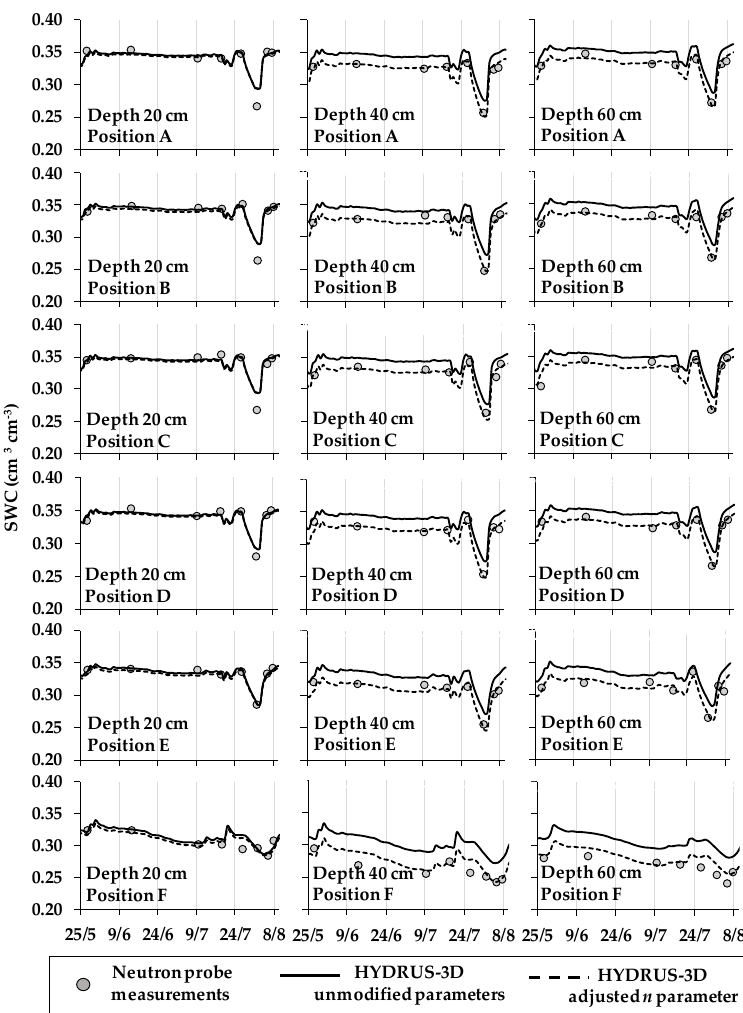
Figure 7. Soil water content (cm 3 cm − 3 ) simulated with HYDRUS-3D versus measurements by neutron probe in 2018 (dots) in different access tubes and at different depths. Continuous lines are simulations using the hydraulic parameters obtained from HYPROP + WP4C. Dashed lines are simulations after the calibration of parameter n. 3.4. Validation of Seasonal HYDRUS-3D Simulations by Comparison with the Dataset of Neutron Probe Measurements in 2017 for Different Access Tubes and Depths The dataset of neutron probe measurements for 2017 (data not included in the previous sections) was compared with the HYDRUS-3D simulations using three different hydraulic parameterizations: